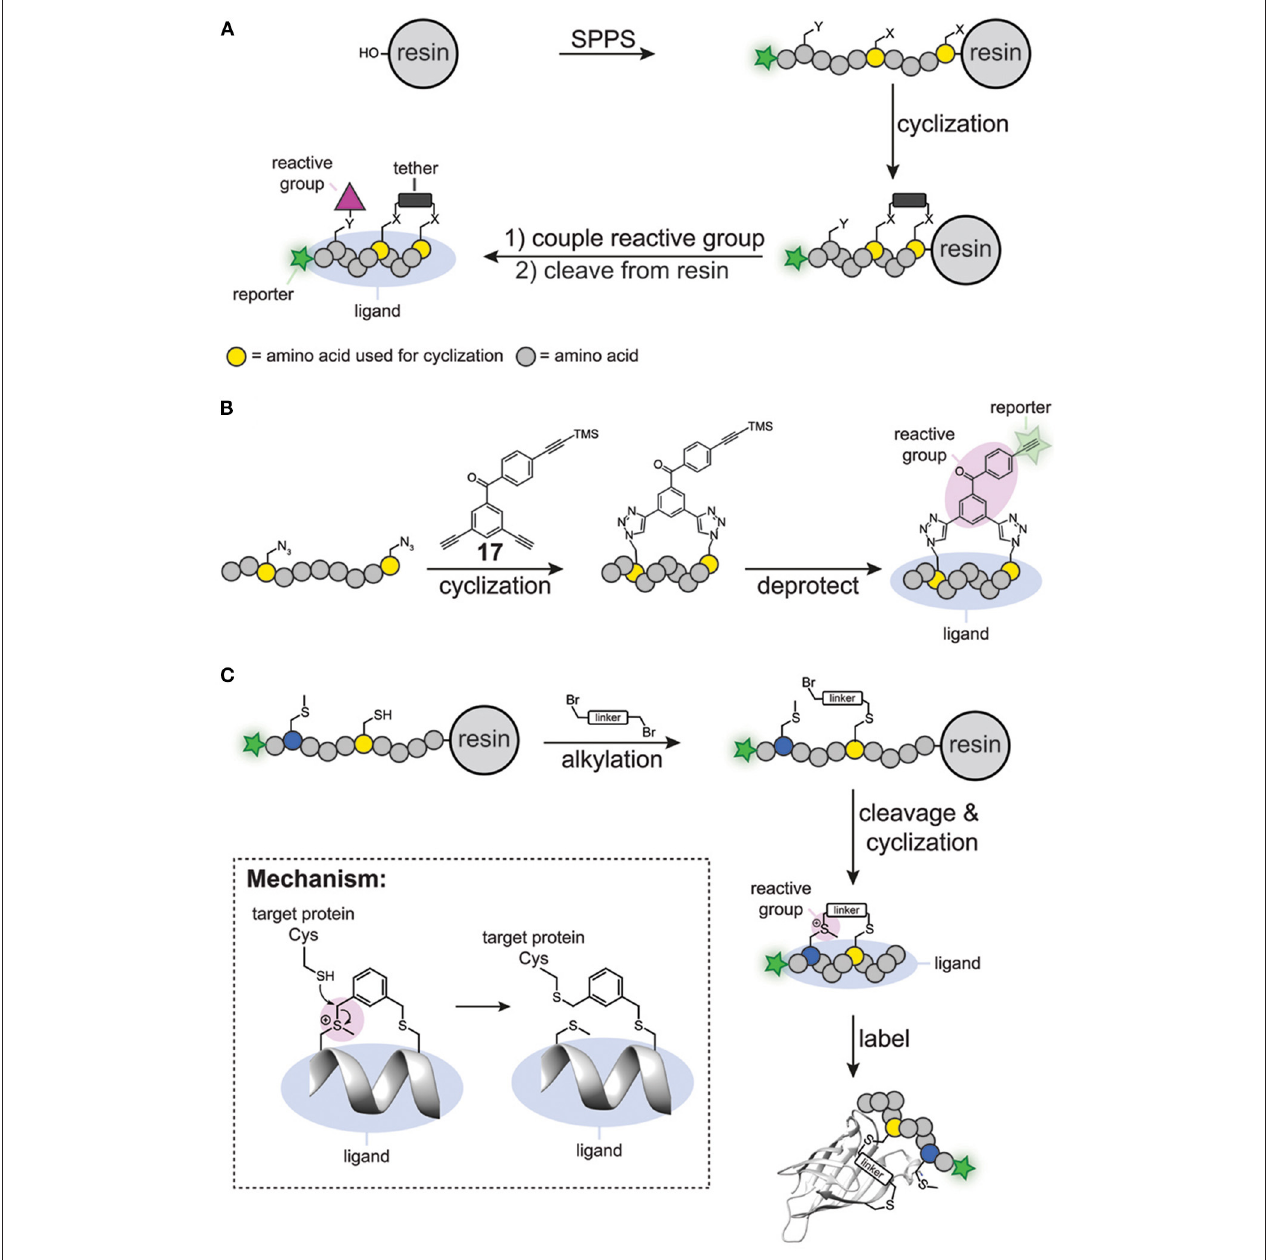
FIGURE 6 | (A) Traditional synthesis of cyclic peptide probes. (B) Schematic representation of simultaneous peptide cyclisation with a clickable benzophenone photocrosslinker ( 17 ). (C) Specific alkylation of a cysteine residue and a methionine residue to prepare cyclic probes. The sulfonium reactive group reacts with cysteine residues within the proximity of the probe binding